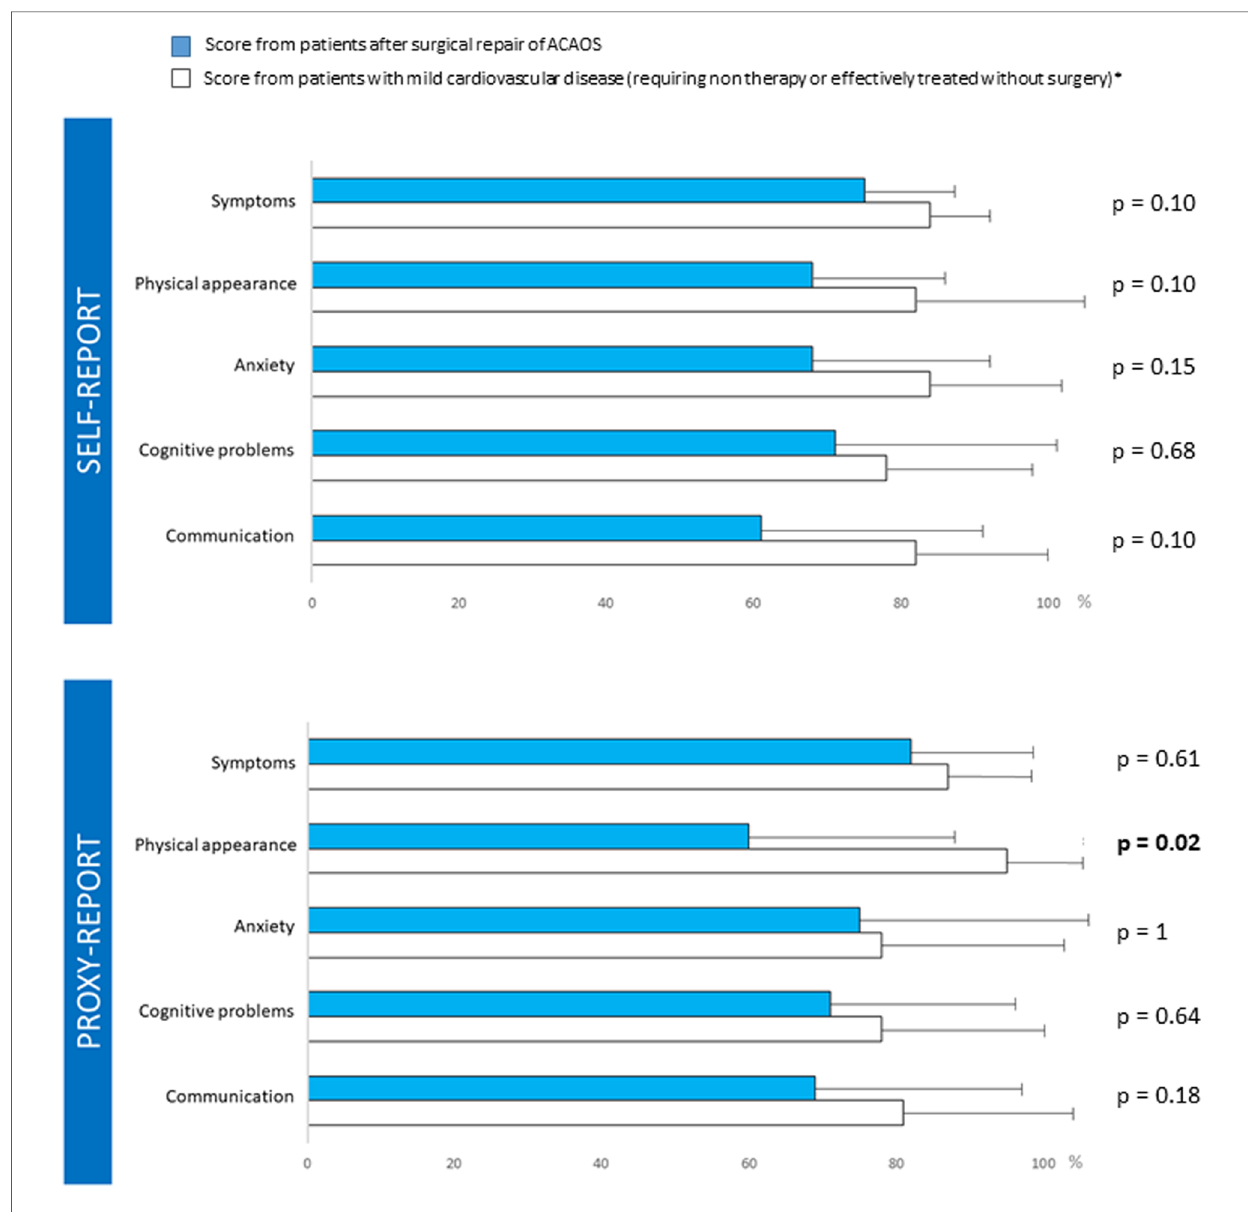
FIGURE 4 Post operative Ped-Qol questionnaires. ** Score from patients with mild cardiovascular disease (requiring non therapy or effectively treated without surgery)